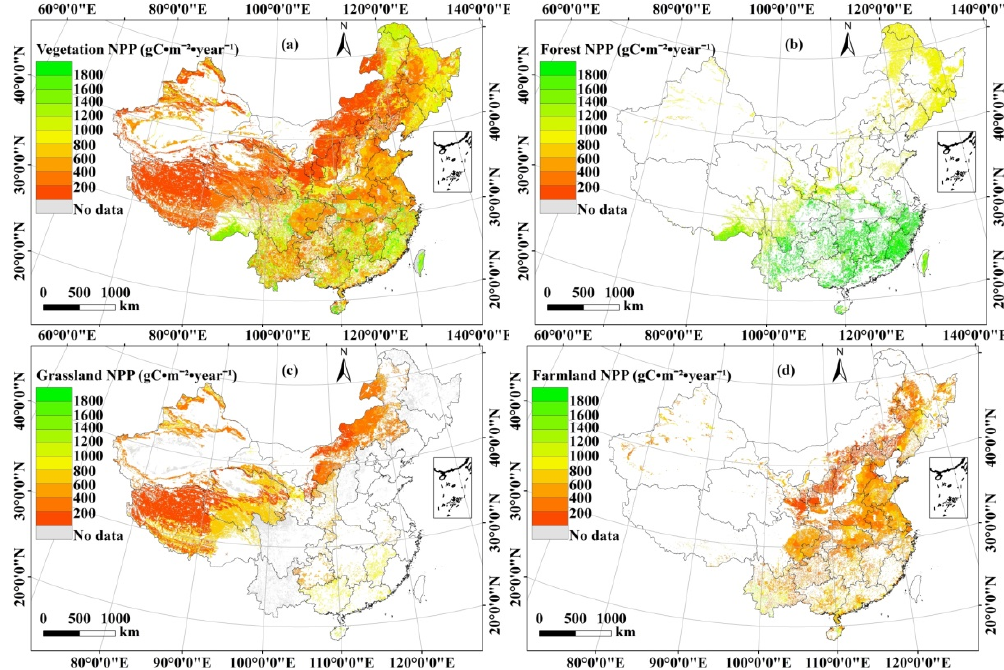
Figure 3. The distribution of vegetation NPP in the 2000s: ( a ) vegetation NPP in the 2000s; ( b ) forest NPP in the 2000s; ( c ) grassland NPP in the 2000s; and ( d ) farmland NPP in the 2000s.